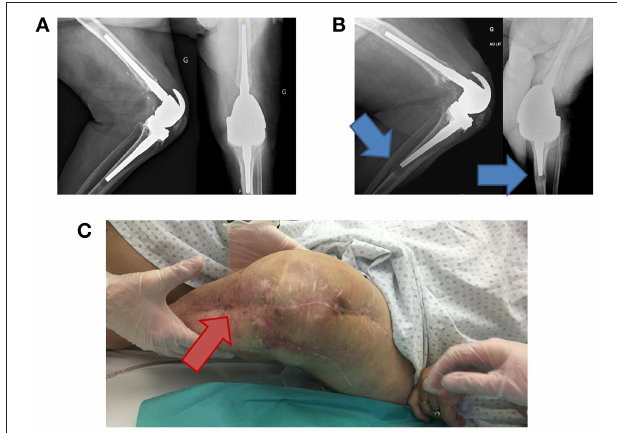
FIGURE 3 | Clinical description of patient #5, a 75-year-old woman. She had a past history of diabetes, Parkinson’s disease, and hypertension. A left knee prosthesis was implanted in 2009. In 2017, she experienced a distal femoral fracture requiring osteosynthesis and then debridement for acute infection. As a pseudarthrosis occurred, a two-stage exchange was performed. Enterobacter cloacae producing extended-spectrum beta-lactamases (ESBL) was found, and imipenem was prescribed and was stopped after the reimplantation. Unfortunately, the patient developed signs of acute infection and a new debridement revealed Pseudomonas aeruginosa and Candida albicans superinfection, with persistence of the ESBL Enterobacter cloacae . The initial therapy included IV imipenem, oral ciprofloxacin, and oral fluconazole. After 6 weeks, imipenem was replaced by IV ertapenem (1 g/12h), and irreductible flessum persisted with mild prosthesis loosening on X-ray (A) . Ciprofloxacin and fluconazole were stopped after 12 weeks and 6 months, respectively. Six months after surgery, ertapenem administered as 1 g/24h by SC route was continued as suppressive therapy targeting the multidrug-resistant Enterobacter cloacae . Unfortunately, prosthesis loosening (B) and purulent discharge occurred (C) (the red arrow points to the fistula from which purulent discharge occurred) revealing the persistence of the ESBL Enterobacter cloacae into the joint, despite ertapenem therapy. It became resistant to